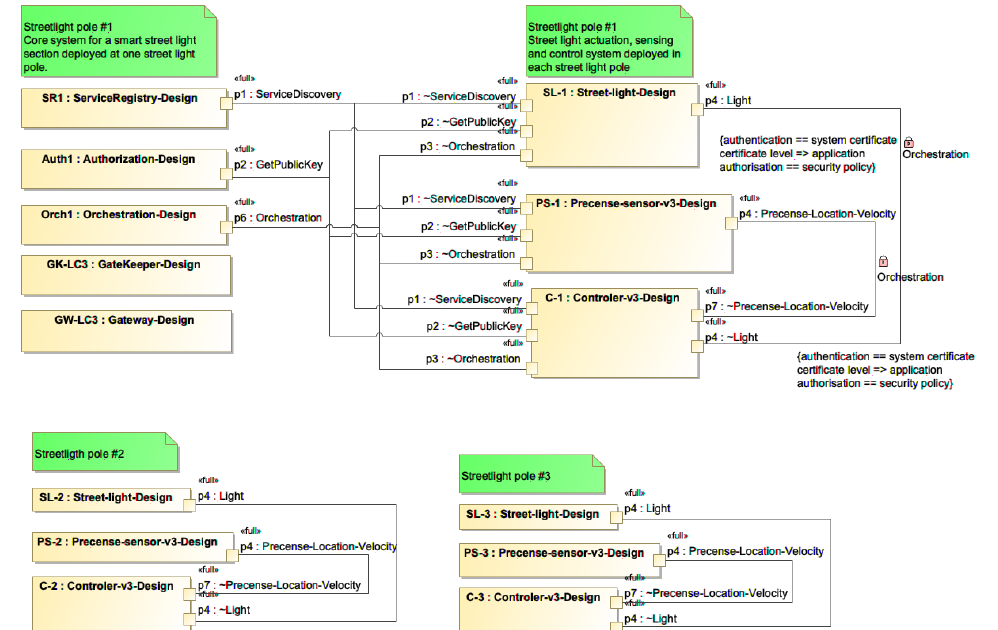
Figure 7. A SysML internal block diagram for a small local cloud of smart streetlight poles, including necessary SOA infrastructure support systems, orchestration principles, and service interaction secu- rity policies. For simplicity, only 3 streetlights have been modelled. Each streetlight has the capability of sensing the presence of objects for which the light should be turned on. Only one streetlight holds the Eclipse Arrowhead core systems ServiceRegistry, Authorization, and Orchestration, which supports the fundamental SOA principle. With the help of these core systems, more streetlights can be added, and defective ones can be replaced with minimal system integration effort and cost. In addition, interaction with other streetlight sections can be established using the Eclipse Arrowhead Gatekeeper and Gateways core systems